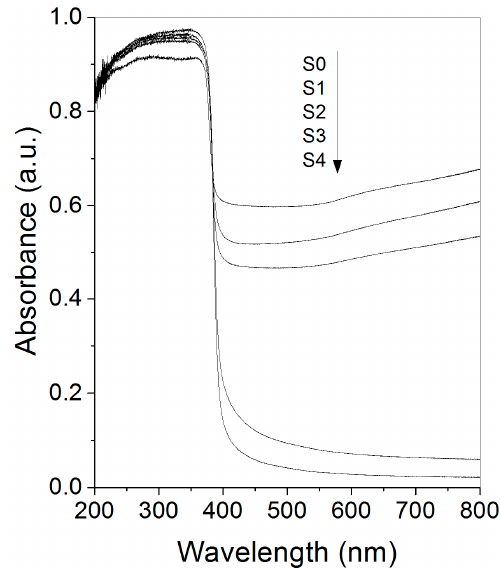
Figure 5. Diffuse reflectance spectra of the precursor powder (S0) and the products obtained by its thermal oxidation (900 ° C; air atmosphere) during different times: 3 (S1), 6 (S2), 12 (S3), and 24 min (S4).